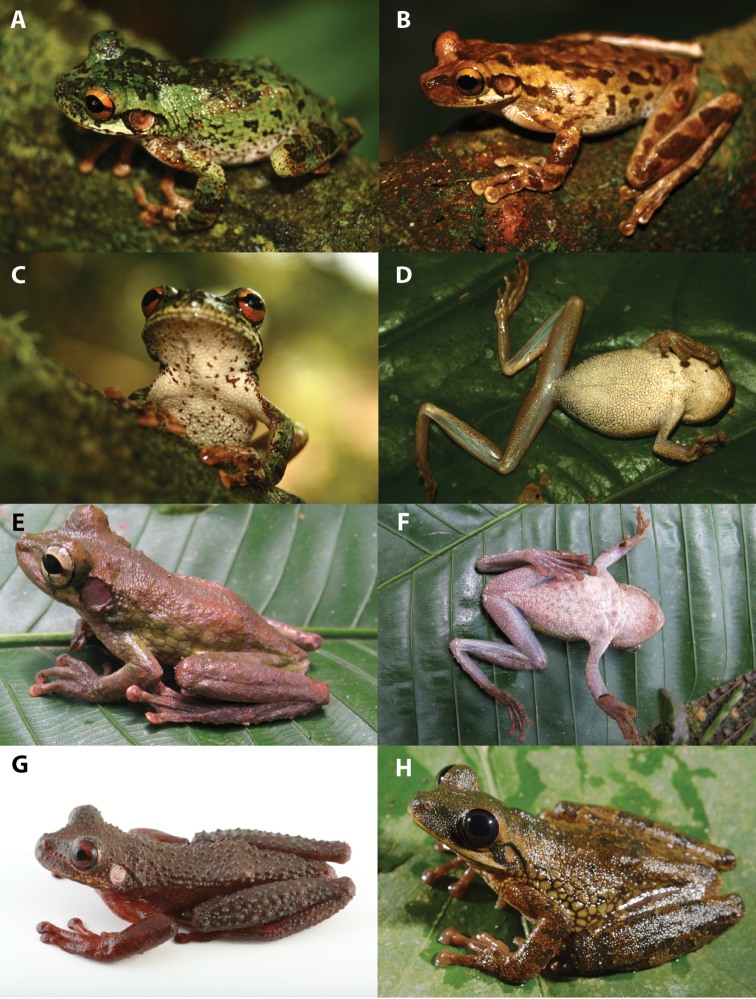
Dorsolateral, frontal, and ventral views of Osteocephalus. A, C
Osteocephalus germani, CORBIDI 05505, adult female, SVL = 49.16 mm, Pongo de Mainique, Peru B, D
Osteocephalus germani, CORBIDI 08284, adult female, SVL = 49.00 mm, Comunidad Nativa Poyentimari, Peru E–F
Osteocephalus vilmae CORBIDI 04773 (holotype), adult male, SVL = 51.85 mm, Pampa Hermosa, Peru G
Osteocephalus verruciger, QCAZ 41115, adult male, 52.37 mm, Pacto Sumaco, Ecuador H
Osteocephalus festae, QCAZ 39801, adult female, SVL = 51.54 mm, Río Napinaza, Ecuador. Photographs A–D by G. Chavez, and E–F by V. Durán.